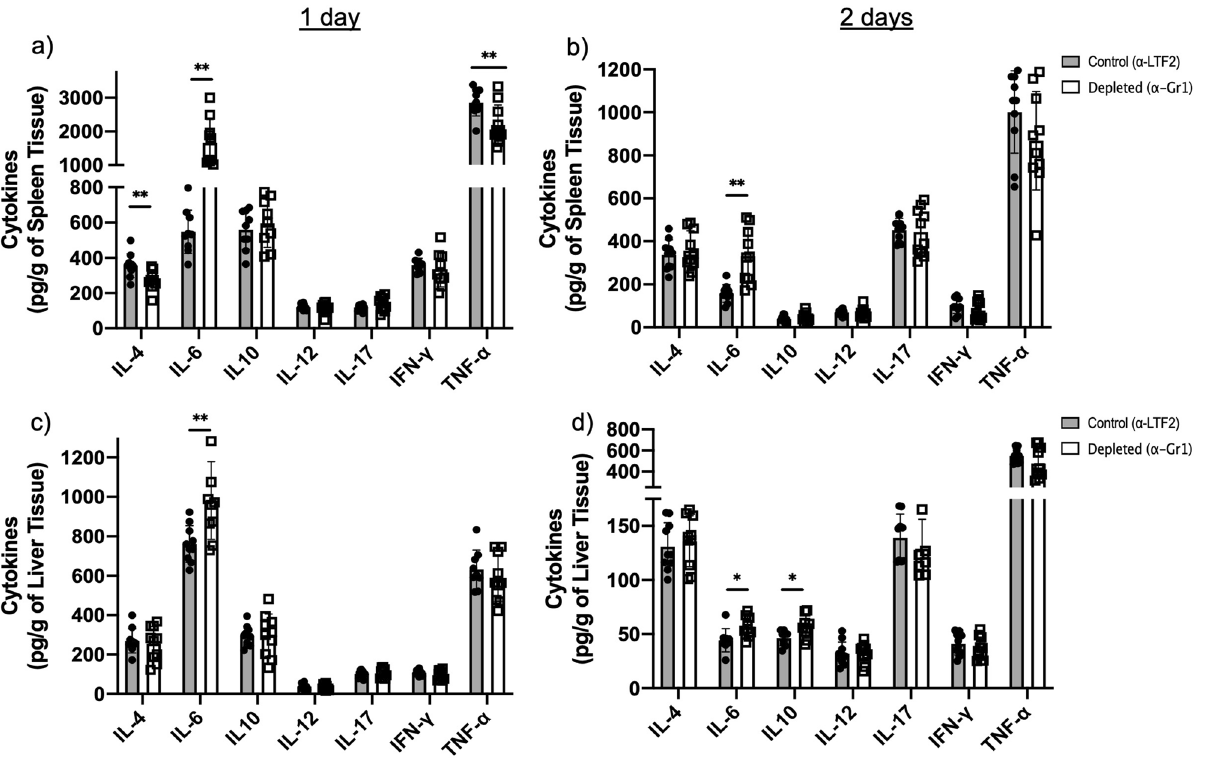
Figure 3. Cytokine production in the spleen and liver of F. pedrosoi- infected animals: We verified an increase in IL-6 production in the spleen and liver of neutropenic animals on day 1 ( a , c ) and day 2 of infection ( b , d ). A decrease in TNF-α in the spleen of neutropenic animals was observed after 1 day of infection ( a ) along with an increase of IL-10 in the liver after 2 days of infection ( d ). Results from two independent experiments (n = 4–5 animals per group and experiment) were compiled together. Values are expressed as the mean ± SD. * p < 0.05; ** p < 0.01, two-tailed unpaired Student t -test.